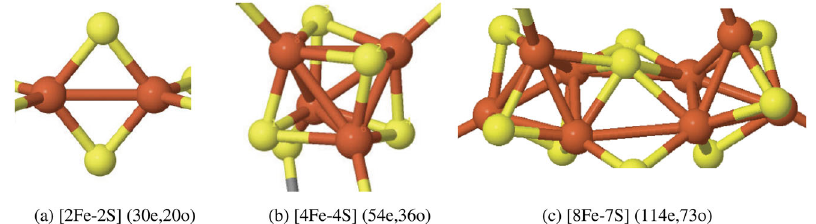
Fig. 4 Iron – sulfur clusters used in the present work, and their active spaces (speci fi ed by numbers of active electrons and orbitals). a [2Fe-2S] (30e,20o), b [4Fe-4S] (54e,36o), c [8Fe-7S]